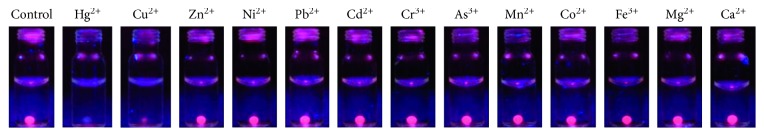
Photographs of vials containing hydrogel beads placed in 1 ppm concentration of various heavy-metal ions. (Copyright @2017 American Chemical Society).